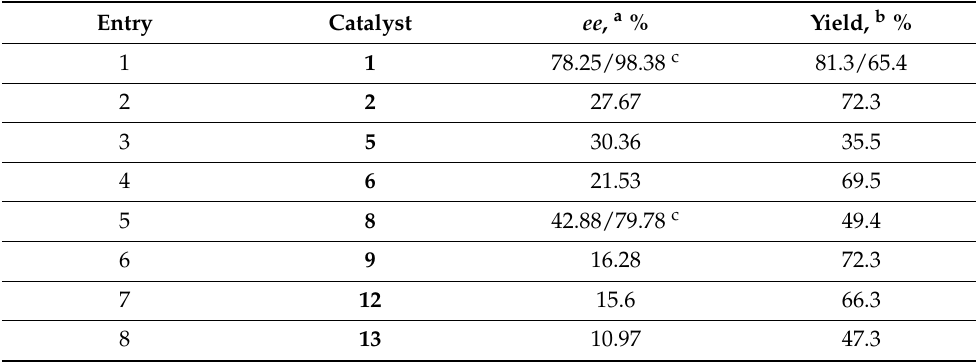
Table 5. C-alkylation of amino acid derivative 19